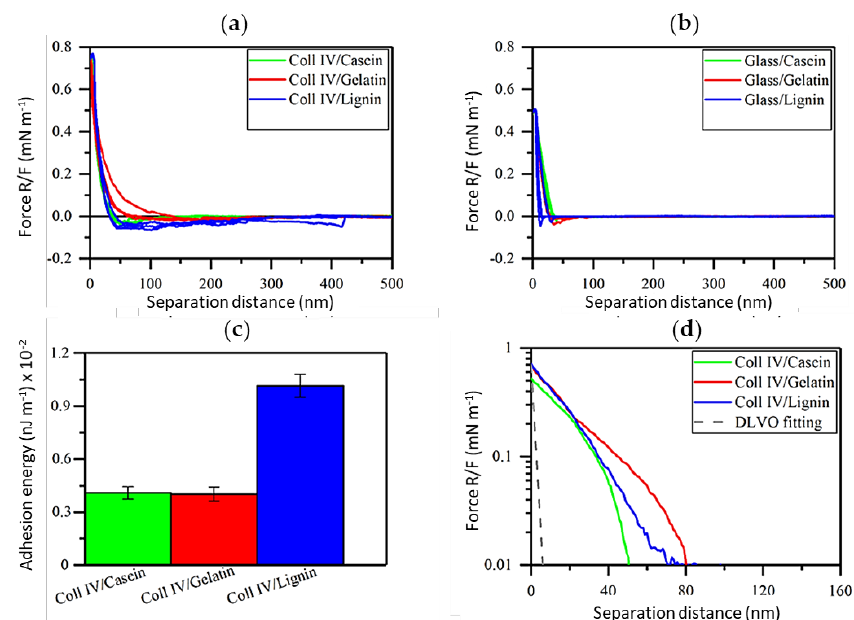
Figure 5. AFM force profiles. Interaction between ( a ) Col IV probe and other proteins and lignin. ( b ) Interaction of the model surfaces with a neat glass probe. ( c ) Corresponding histograms of mean adhesion energy of above interactions including standard deviation. ( d ) DLVO fitting of the data presented in ( b ). The gray dashed line represents the DLVO fitting for PBS (150 mM) at pH 7.4. All force profiles were normalized with the radius of the probe.